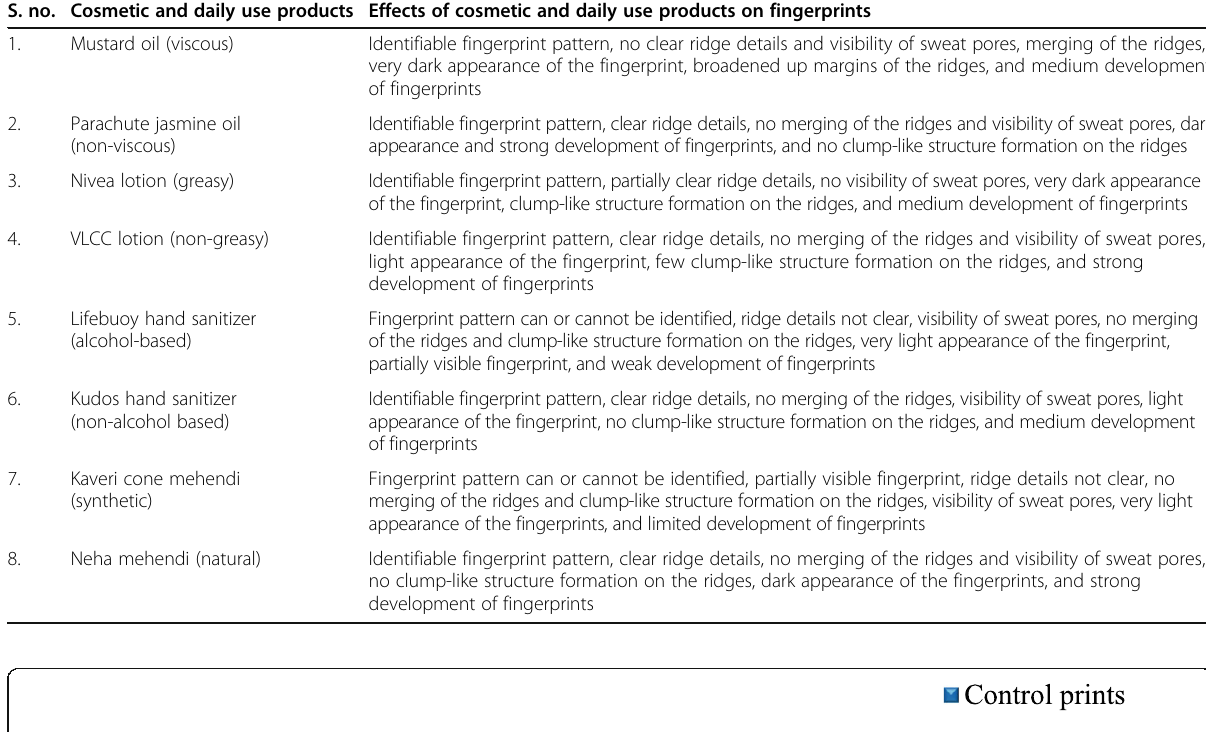
Table 2 Comparison showing effects of products on fingerprints